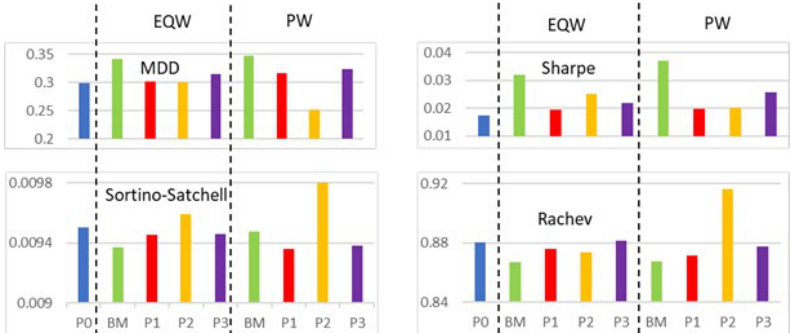
Figure 5. Total time period risk measures for the α = 0.95 portfolios constrained by a daily turnover of 0.4%. (BM = benchmark; P0 = P 0 , 0.95